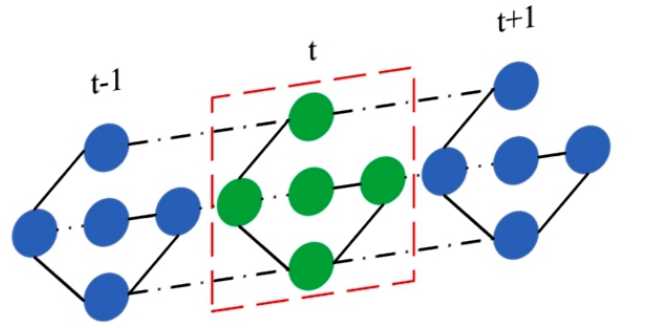
Figure 4. Cropping operation of h agg